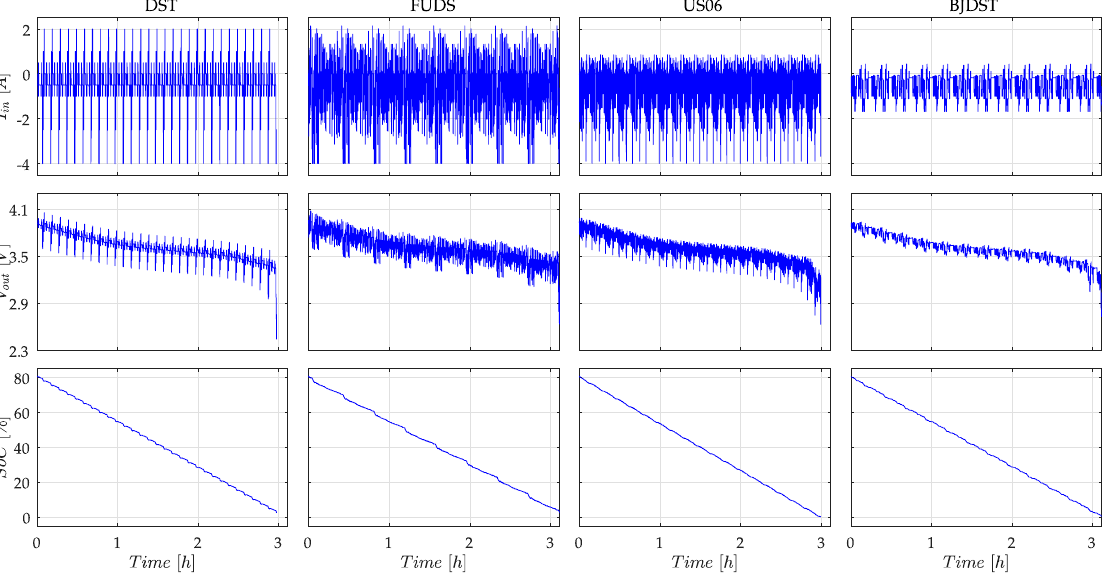
Figure 15. INR 18650-20R cell time series I in , V out , T in , SoC of the dataset DST, FUDS and US06.